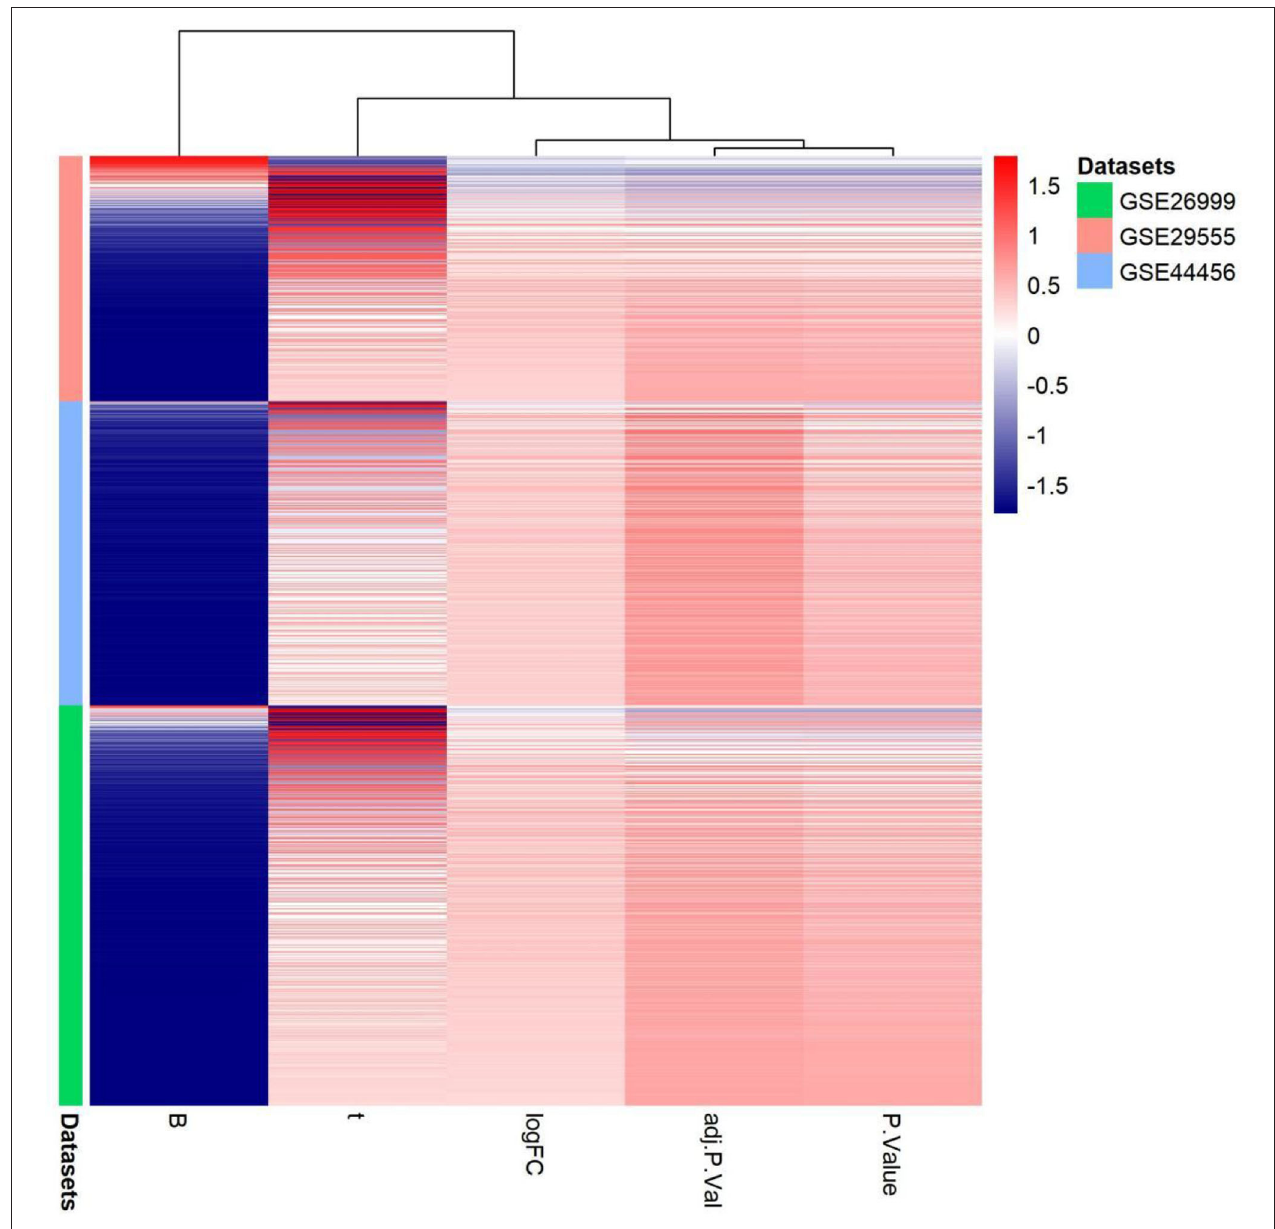
FIGURE 8 | Gene expression patterns in the three gene expression datasets: GSE29555, GSE44456, and GSE62699. Upregulation of genes is marked in red; downregulation of genes is marked in blue.